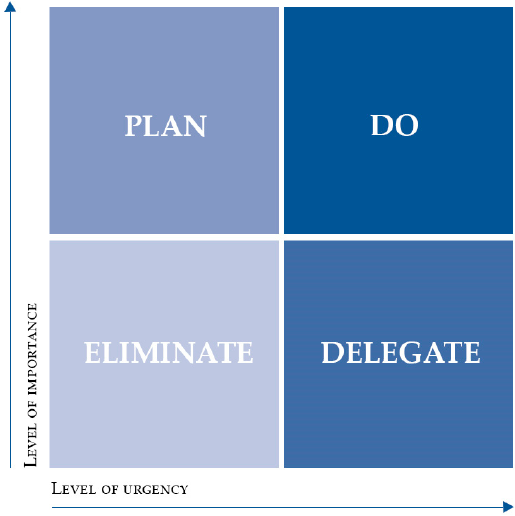
Figure 3. Eisenhower priority